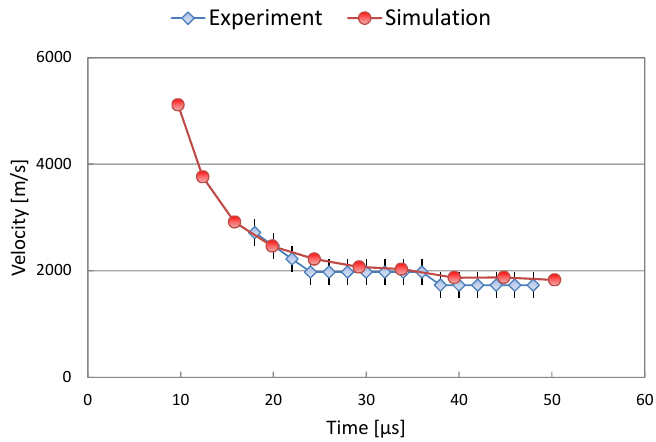
Figure 4. Shock wave velocity comparison of the experimental and computational results.